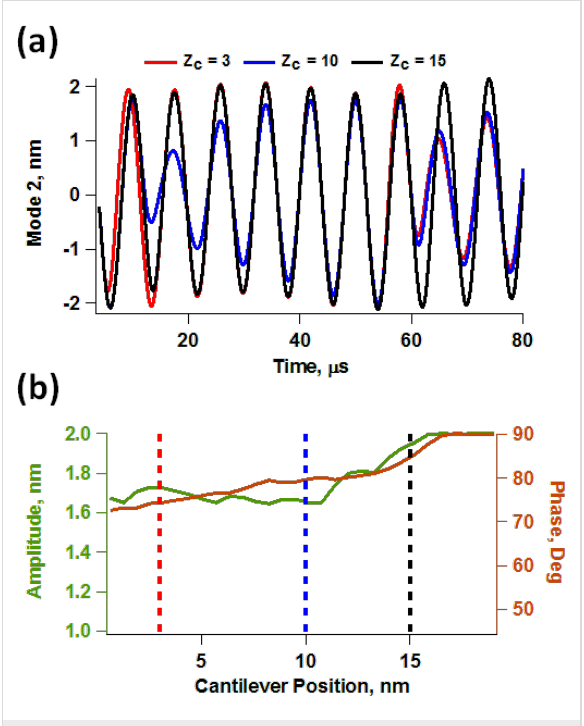
Figure 5: (a) Illustration of the drastically varying response of the higher eigenmode as the cantilever is brought closer to the sample ( Z c denotes the cantilever position above the sample); (b) second phase response for the three responses shown in (a).